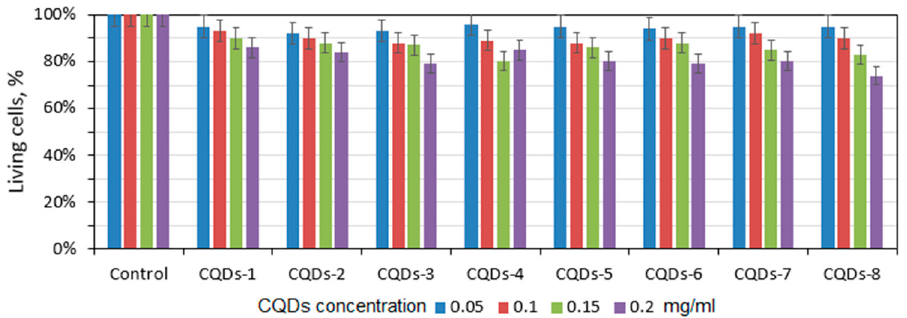
Figure 11. Results of the XTT assay carried out on L929 mouse fibroblasts at four di ff erent concentrations: 0.05 mg / mL, 0.1 mg / mL, 0.15 mg / mL and 0.2 mg / Figure 11 . Results of the XTT assay carried out on L929 mouse fibroblasts at four different concentrations: 0.05 mg/mL, 0.1 mg/mL, 0.15 mg/mL and 0.2 mg/mL .